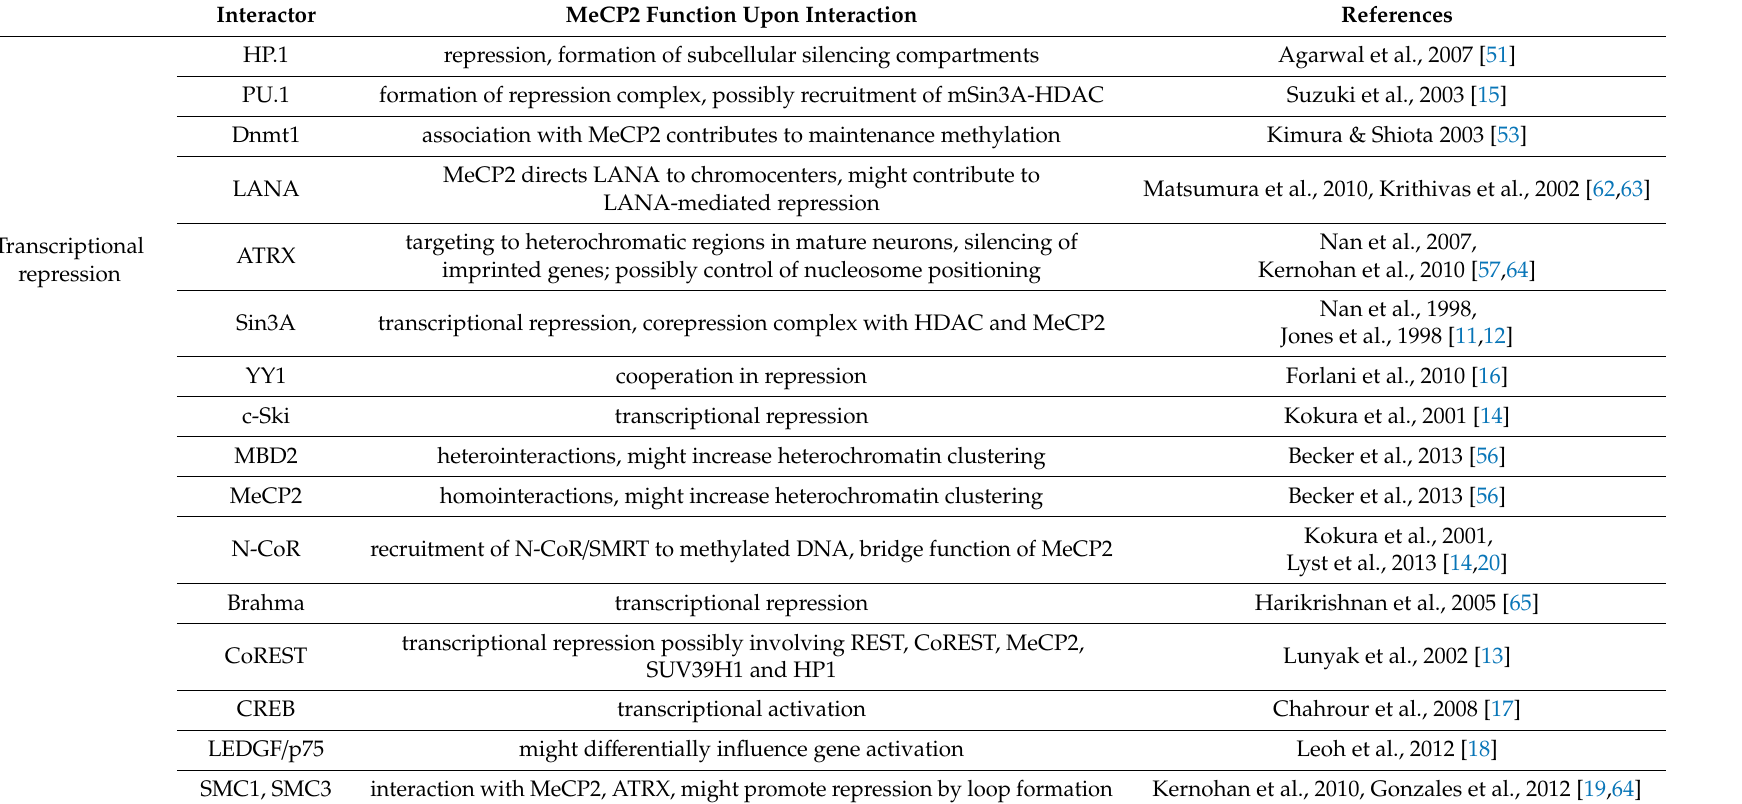
Table 1. MeCP2 interaction partners and function upon